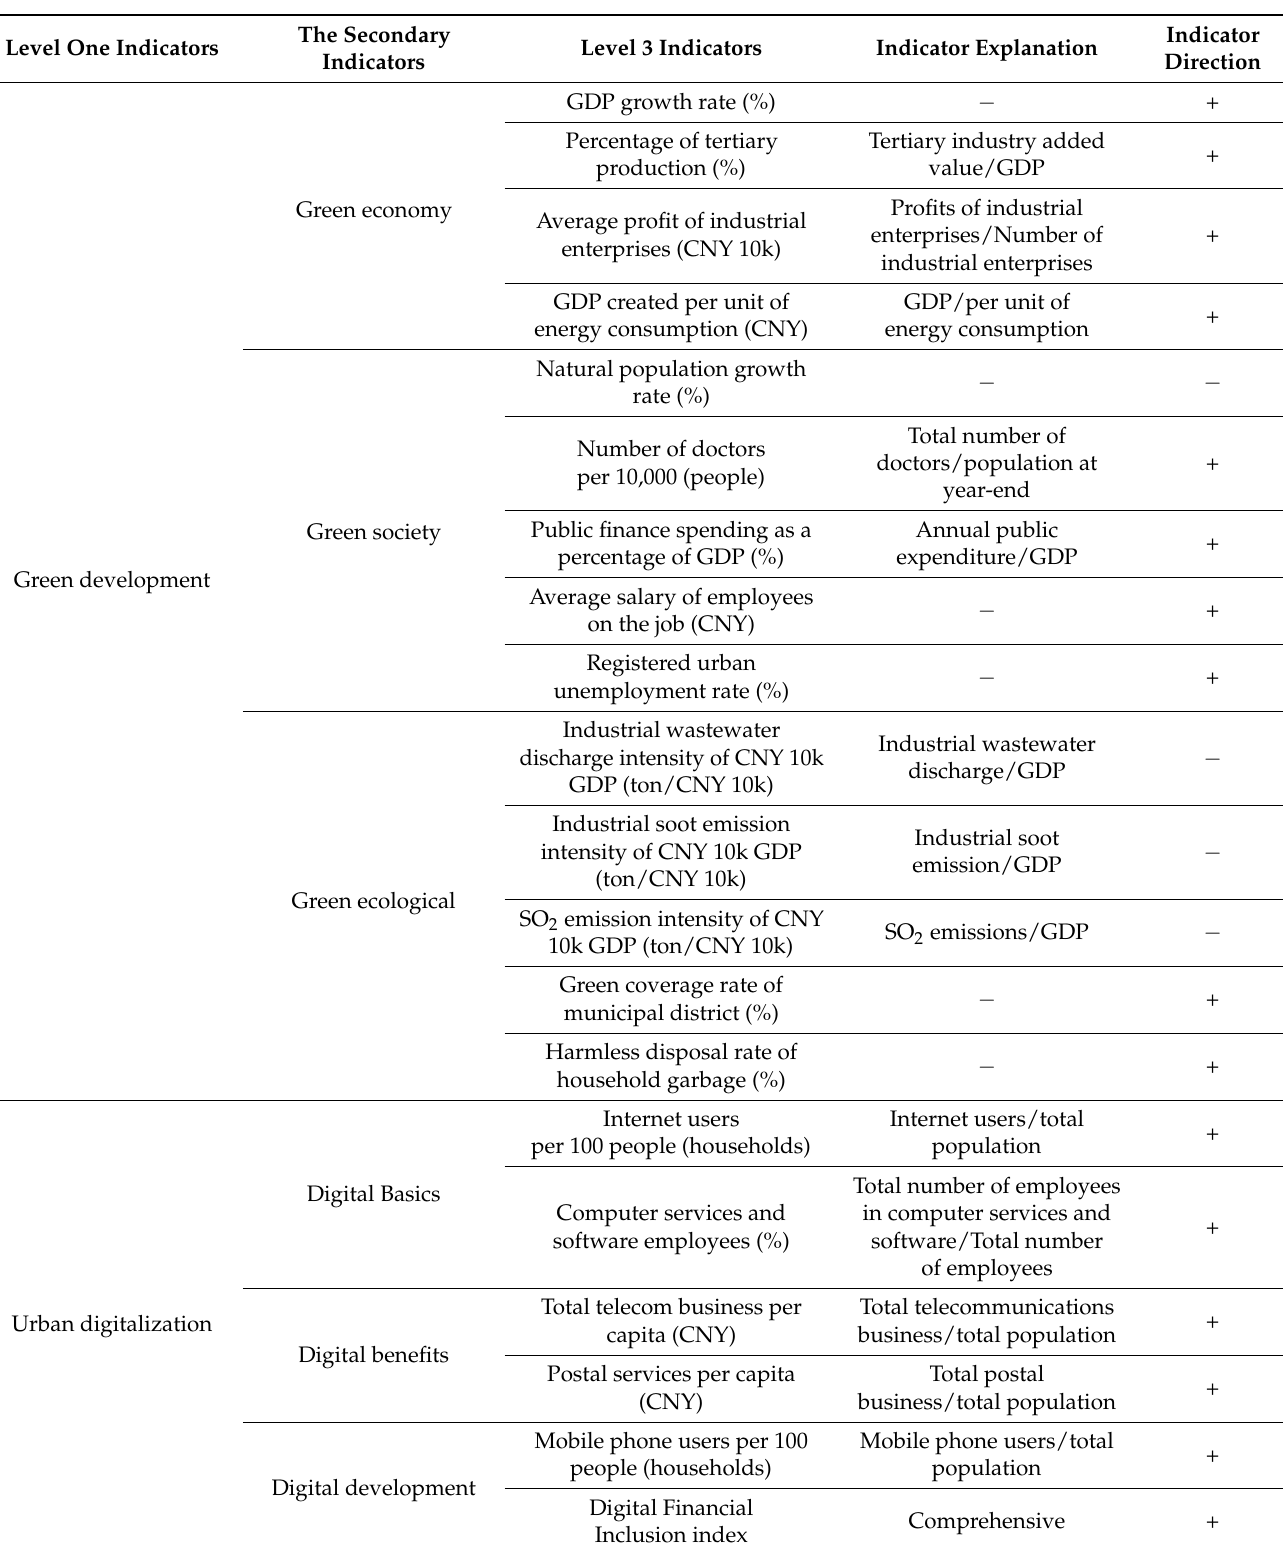
Table 1. Indicator system of urban digitalization and green